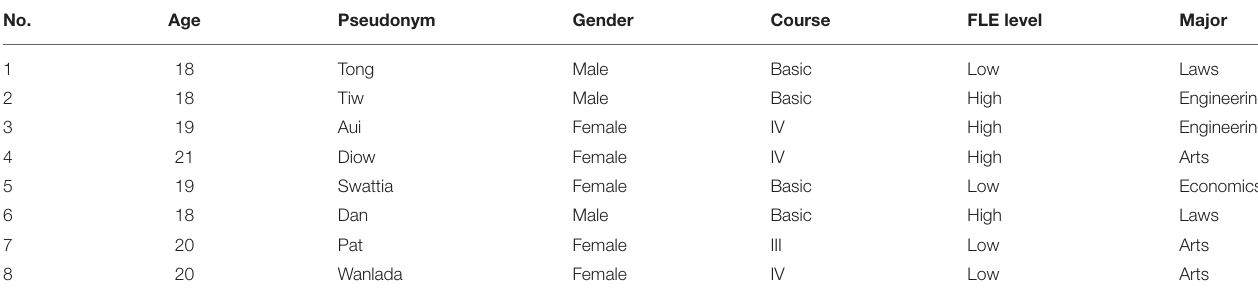
TABLE 3 | Interviewees’